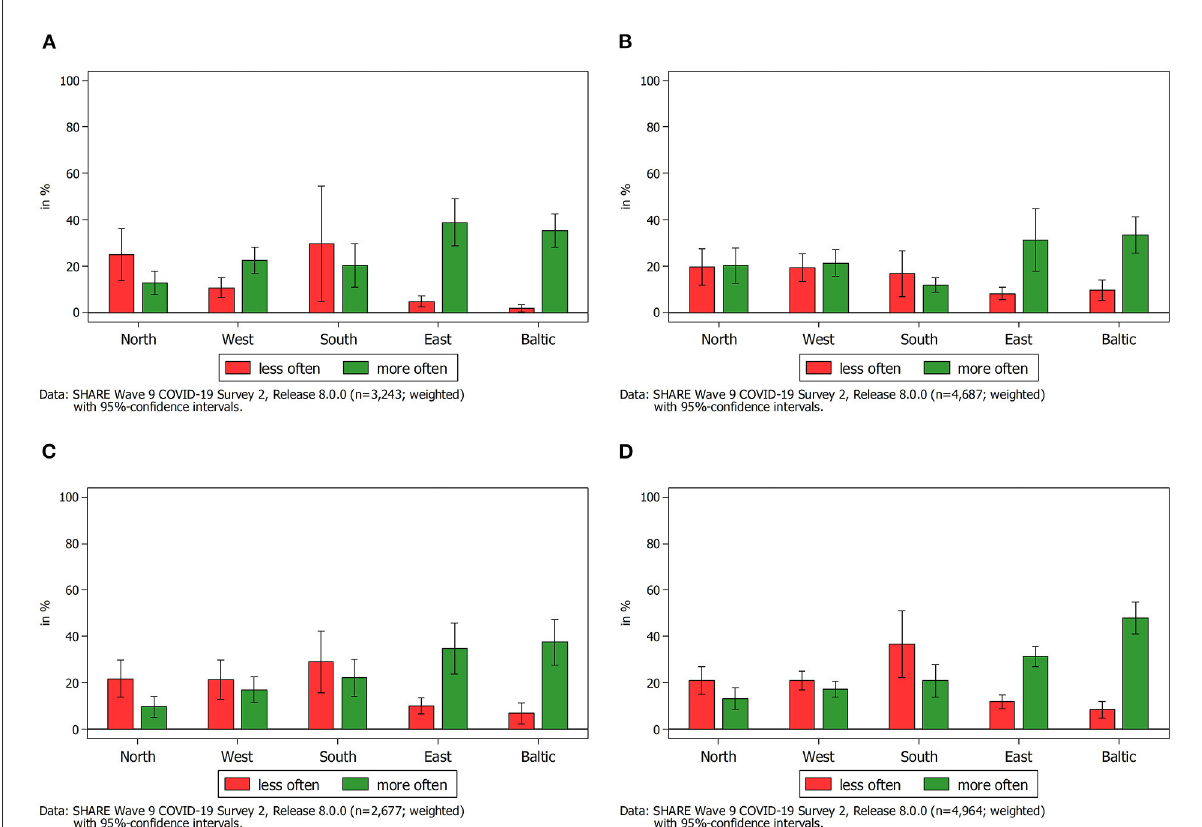
FIGURE3 Change in frequency of providing help to someone outside the own household compared to the first wave of the pandemic by type of relationship. (A) Help provided to parents outside the household compared to the first wave of the pandemic. (B) Help provided to children outside the household compared to the first wave of the pandemic. (C) Help provided to other relatives outside the household compared to the first wave of the pandemic. (D) Help provided to other non-kin outside the household compared to the first wave of the pandemic.